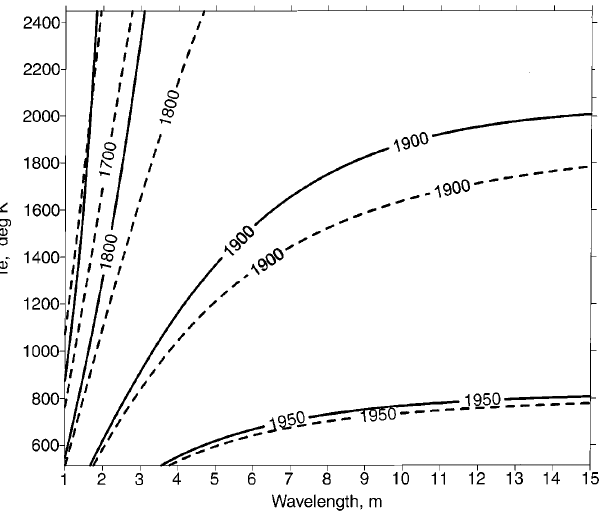
Fig. 4. Contours of the phase velocities (m/s) of the Farley-Buneman instability for wave vectors parallel to the E 0 (cid:2) B drift. The calculations were made for a 2000 m/s electron drift at 110 km altitude. Solid contour lines : exact solutions to the classical isothermal ( t e 1 (cid:136) 0) Farley-Buneman instability. Dashed contour lines : exact solutions to the Farley-Buneman instability using Eqs. (37)